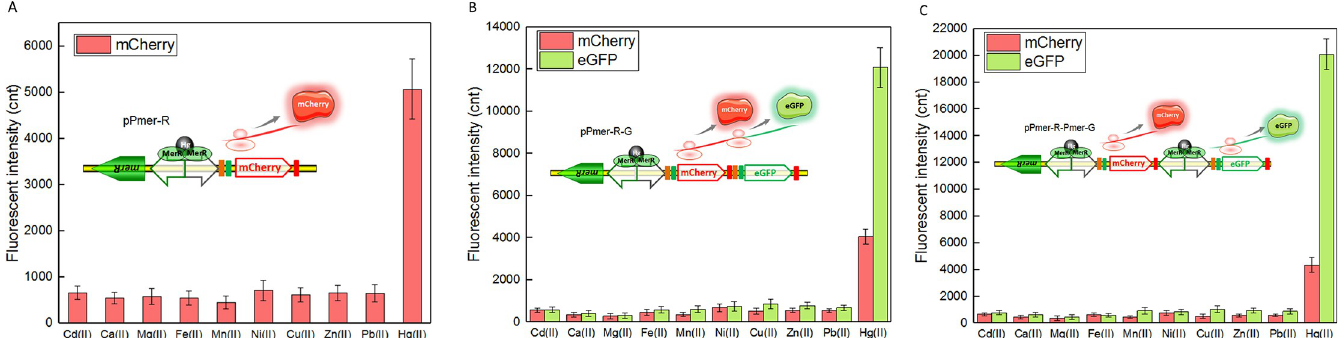
Fig 3. The response of three mercury biosensors exposed to different metal ions at 10 μ M. After induction with 10 μ M various metal ions at 37˚C for 12 h, two kinds of fluorescent signals were all determined. The data were obtained by subtracting the value of recombinant E . coli with no metal ion exposure from that of each group. (A) TOP10/pPmer-R. (B) TOP10/pPmer-R-G. (C) TOP10/pPmer-R-Pmer-G. Fluorescence intensity values were divided by the absorbance at 600 nm in order to normalize to bacterial cell concentration. Data are representative of at least three independent experiments, and the values are expressed as mean ± SD.